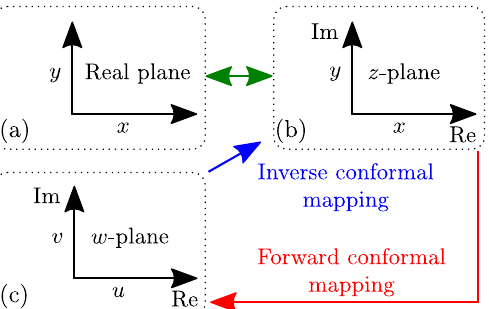
Figure 6. Mapping workflow. Euclidean plane ( a ); Complex z plane ( b ); Complex w plane ( c ). Original Zh barrier lines with corresponding x , y vertices are written as z = x + j y (Figure 7a, red) and conformally transformed to w -plane via w = ln z complex function as w = u + j v (Figure 7b, red).